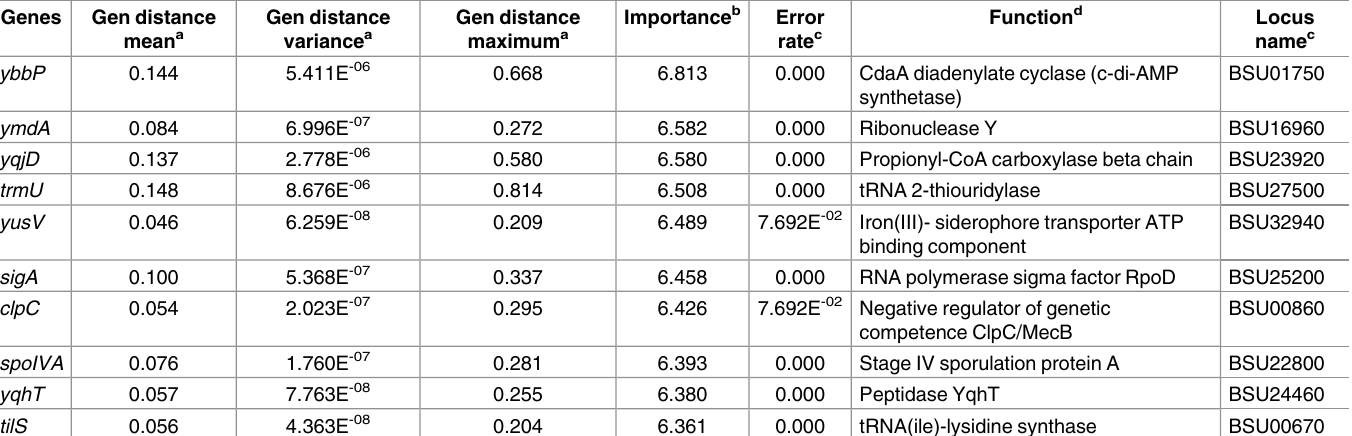
Table 2. Statistics of the 10 most important genes for RF species circumscription.